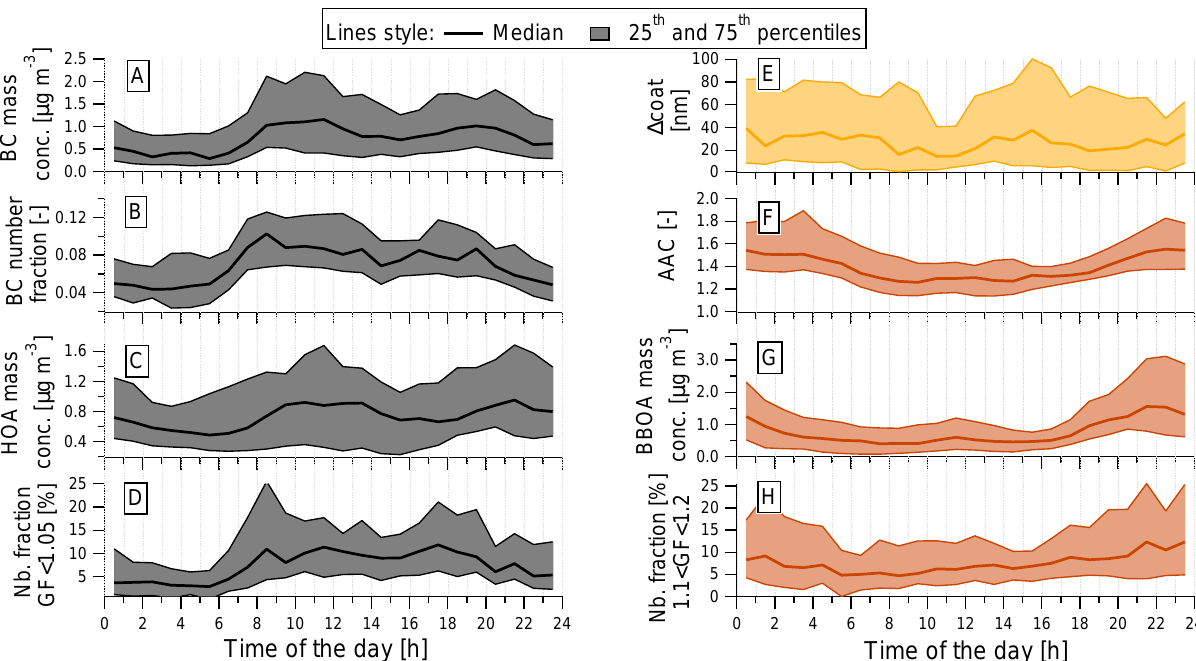
Fig. 9. Diurnal cycles of median, 25 th and 75 th percentiles of: (A) the BC mass concentration (SP2); (B) the relative number fraction of BC-containing particles (SP2) to the total number of particles (CN; measured by the SMPS); (C) the HOA mass concentration as retrieved from the HR-ToF-AMS measurement; (D) the number fraction of non-hygroscopic particles with GF ≤ 1.05 (HTDMA at 90%RH); (E) the coating thickness of non-refractory matter on BC cores with a D MEV between 180–220nm (SP2); (F) the absorption ˚Angstr¨om exponent (calculated from the aethalometer data using Eq. 6); (G) the BBOA mass concentration as retrieved from the HR-ToF-AMS measurement; (H) the number fraction of slightly-hygroscopic particles with 1 . 1 ≤ GF ≤ 1 . 2 (HTDMA at